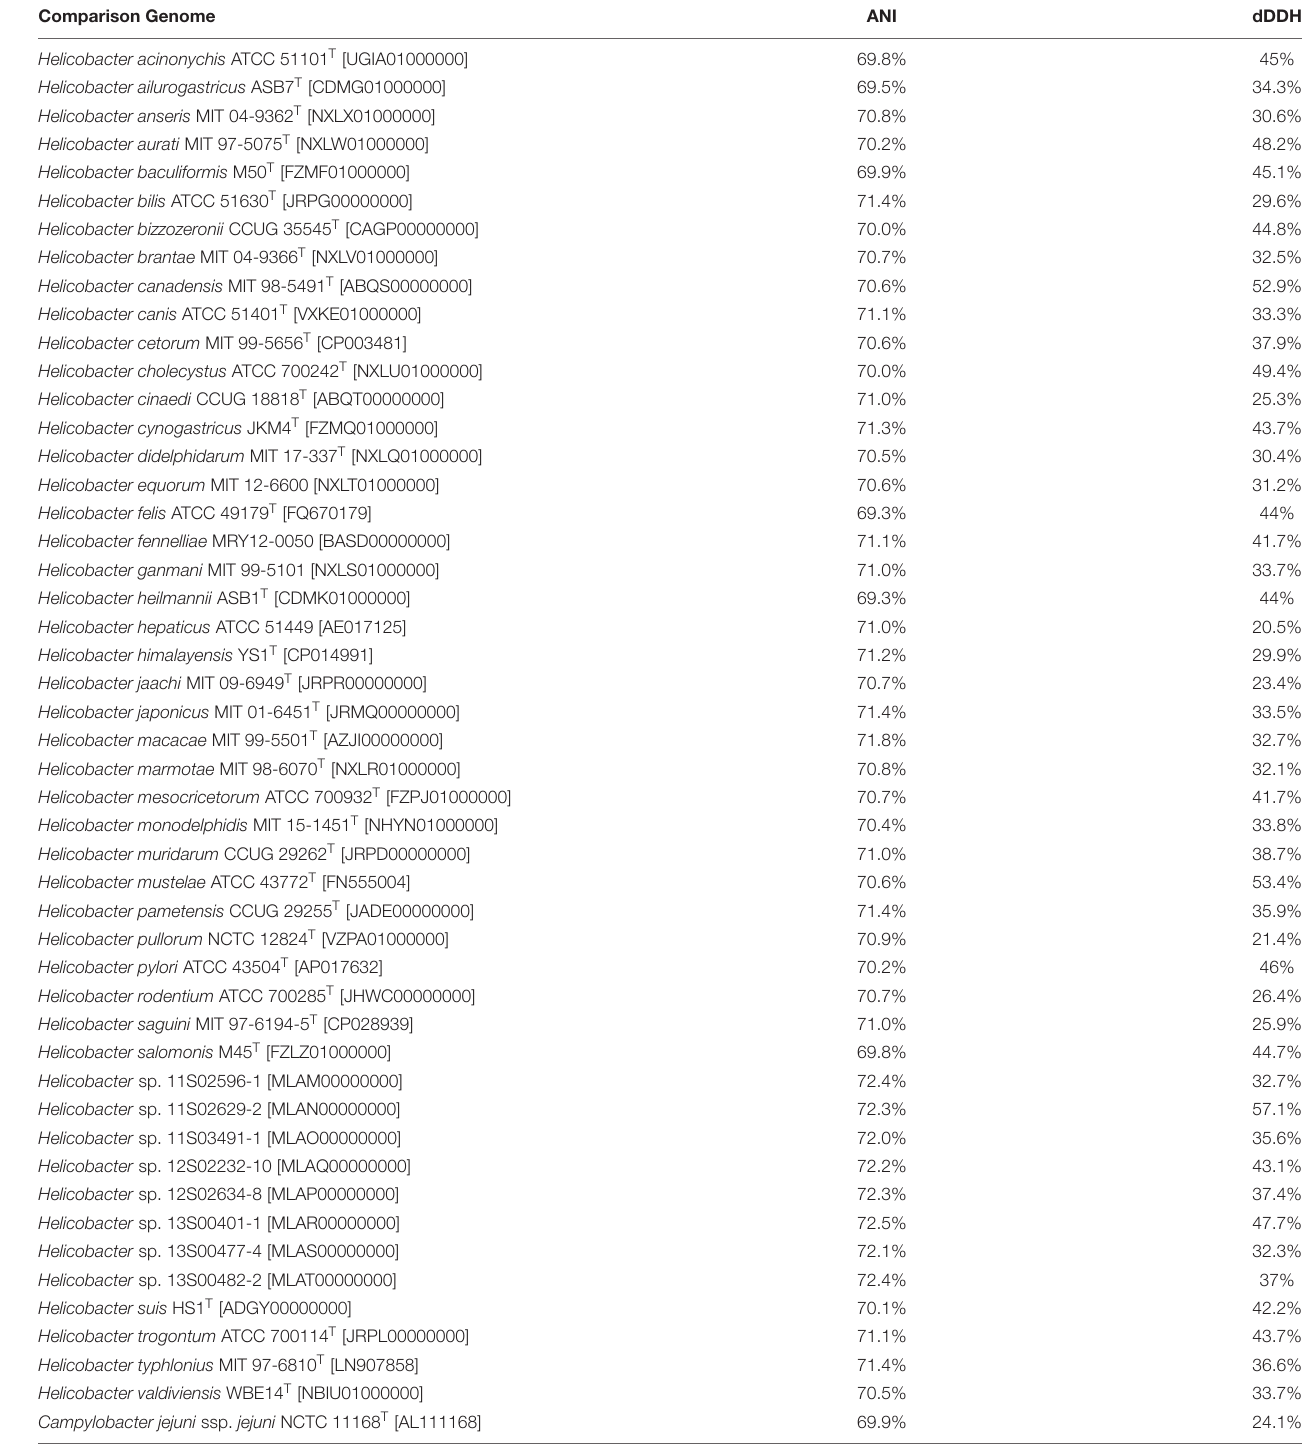
TABLE 3 | ANI and dDDH values for Helicobacter cyclurae MIT 16-1353 [NHYM00000000] vs. other Helicobacter species genomes. Comparison Genome ANI